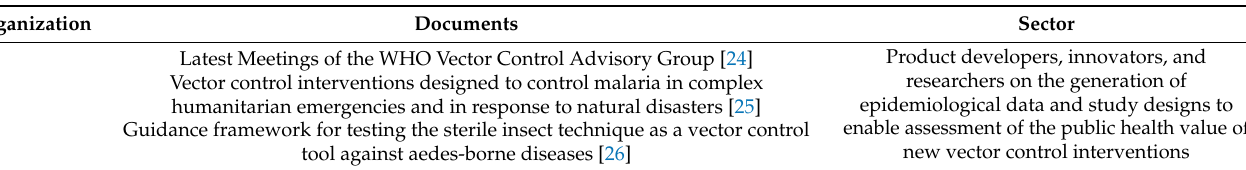
Table 1. Frameworks, guidelines, reviews, manuals, and protocols published by International Organizations and their application